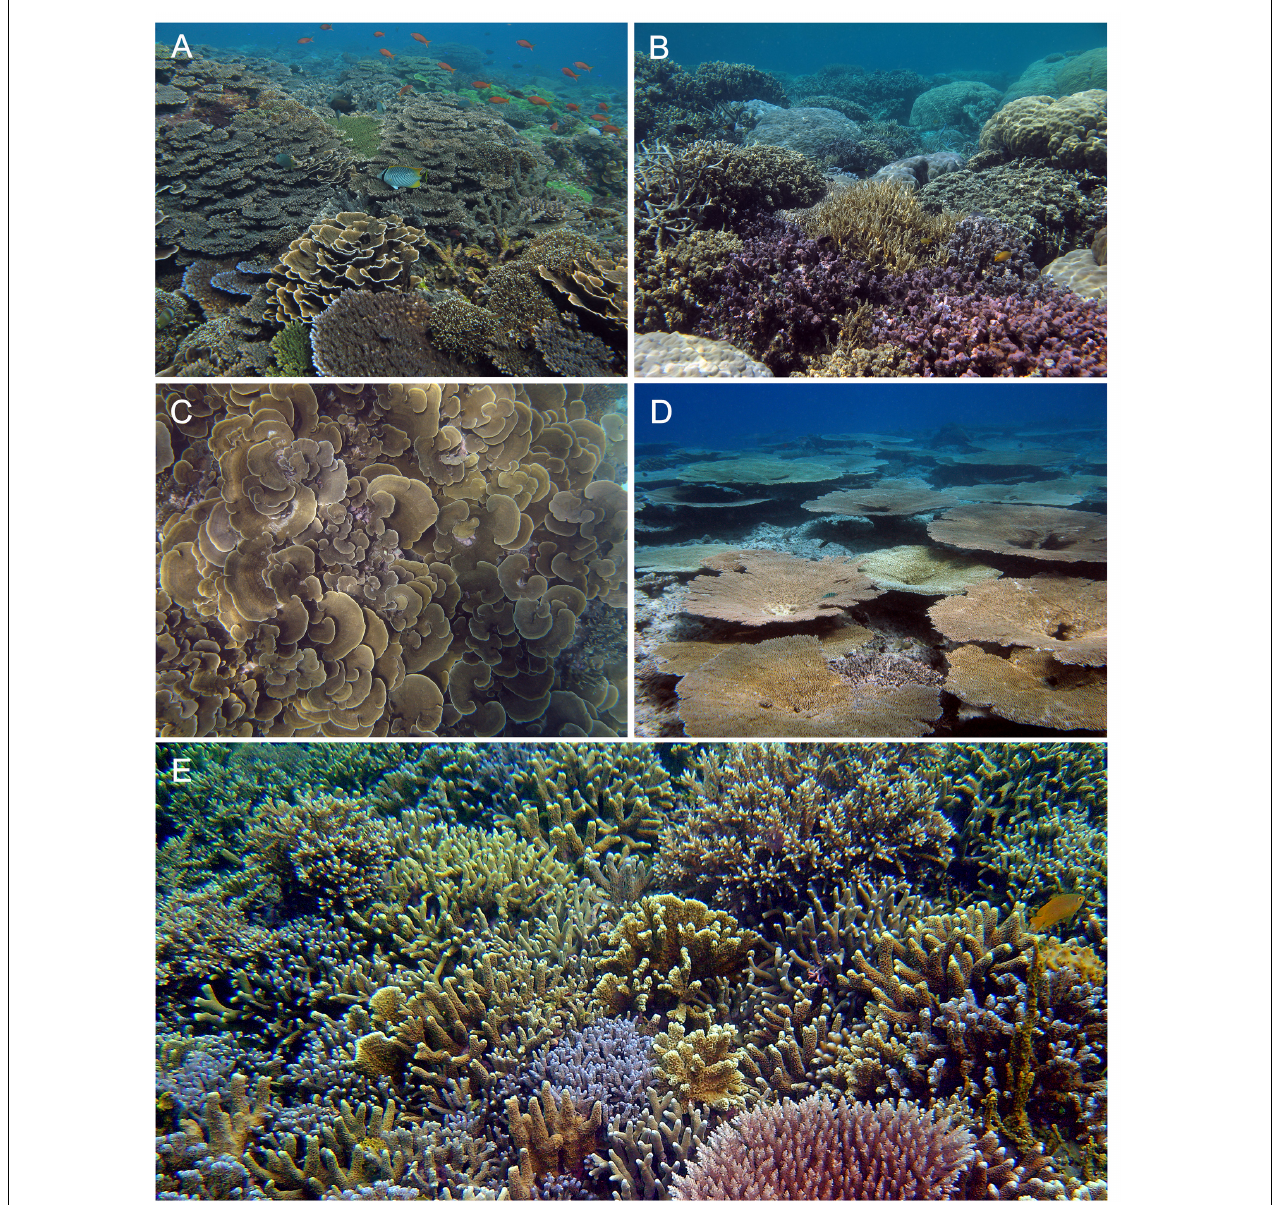
FIGURE 7 | Photos illustrating various forms of the relation between local species richness and high coral cover: (A) moderate richness of Acropora and Montipora spp. growing in close proximity, Bali, Indonesia, 2008; (B) moderate richness of massive and submassive species of Porites , including P. rus (foreground), Pachyseris rugosa , and Echinopora horrida , Anambas Islands, Indonesia, 2012; (C) monospecific stands of Montipora aequituberculata , Palawan, Philippines, 2009; (D) monospecific tables of Acropora cytherea , fostering local recovery a decade following mass bleaching, Palau, Micronesia, 2009. In the absence of further disturbance, the tables would occupy most remaining space within several years, overtopping each other in the process; and (E) rich assemblage of Porites , Acropora , and Montipora spp. growing in close proximity, and with Acropora microclados (bottom right) overtopping neighboring Porites spp., Cenderawasih Bay, Indonesia,